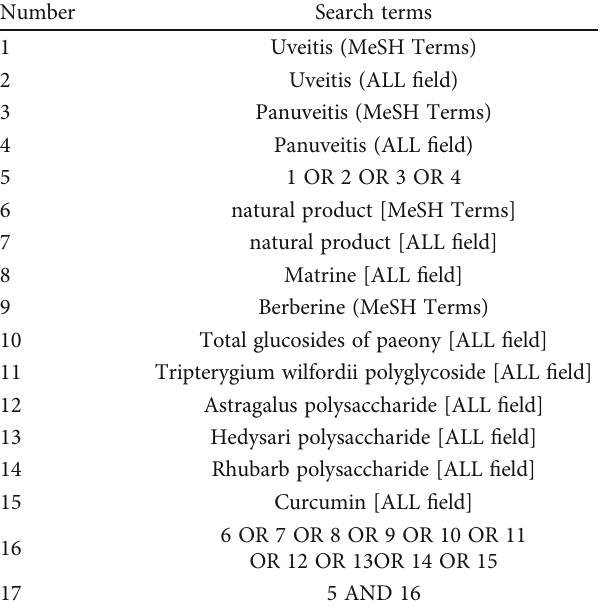
Table 1: Search strategy in